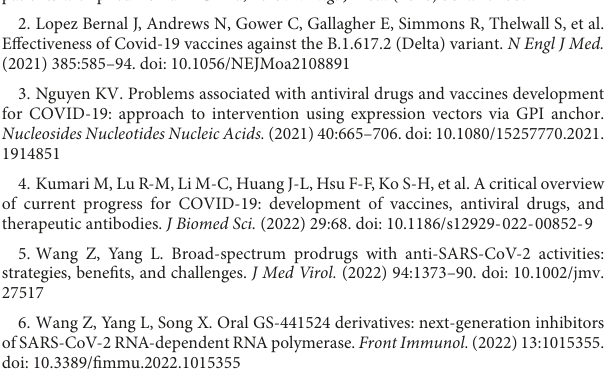
figshare.22220275.v1. Further inquiries can be directed to PG,